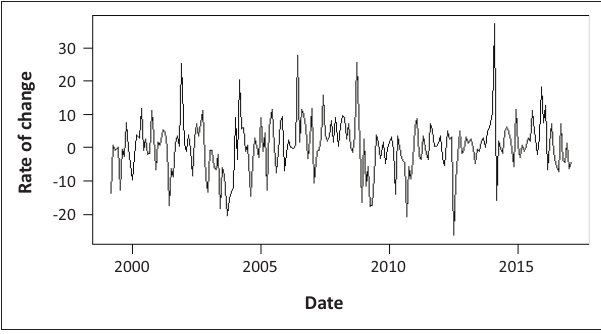
FIGURE 4: South Africa – Movement of the exchange market pressure index (1999–2017).